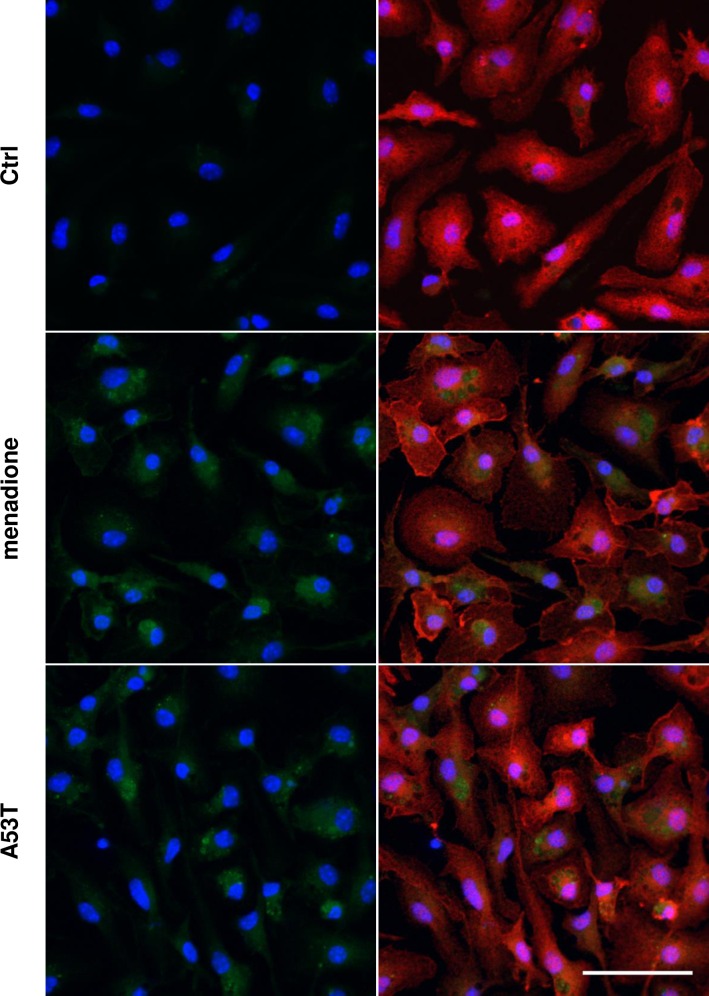
A53T protein promotes ROS production.Primary microglial cells were treated for 2 h with the A53T protein (5 μM) as well as with a reactive oxygen generator (menadione, 10 μM). After treatments, cells were incubated for 20 min with the 6-carboxy-2',7'-dichlorodihydrofluorescein diacetate (carboxy-H2DCFDA, 2 μM) probe. This nonfluorescent probe was converted to a green-fluorescent form by the activity of ROS within cells. Cells were also labeled with the microglial marker Iba1 (red) and counterstained with nuclear stain DAPI (blue). Scale bar: 50 μm.